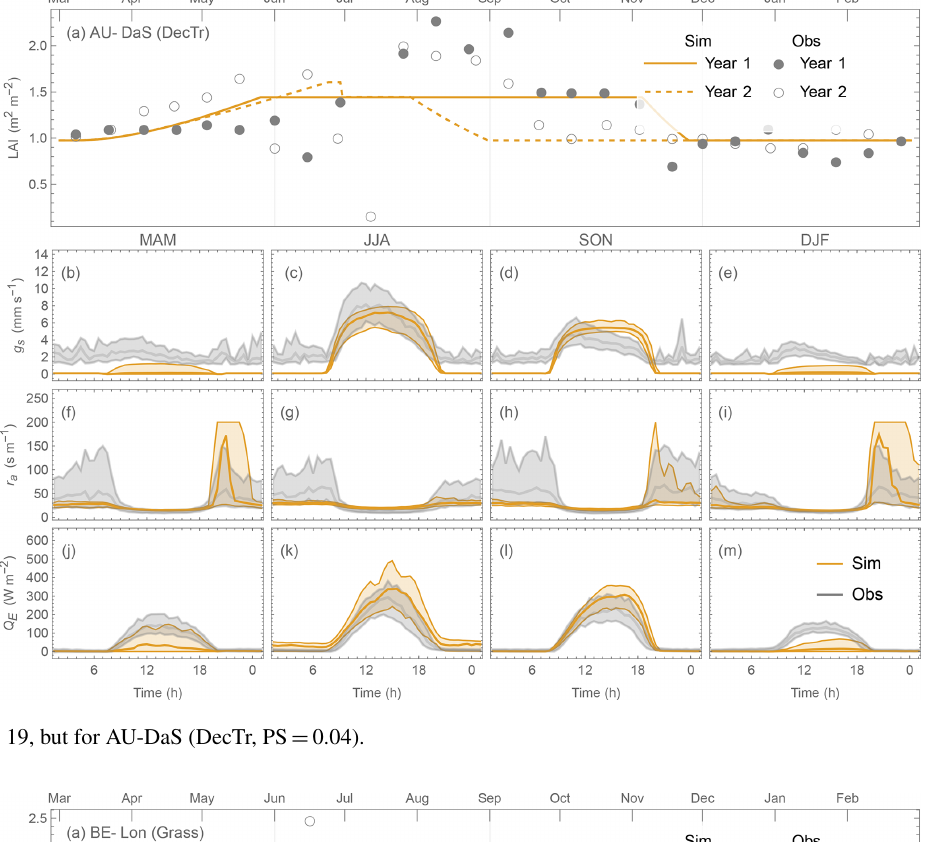
Figure 22. As Fig. 19, but for AU-DaS (DecTr, PS = 0.04).